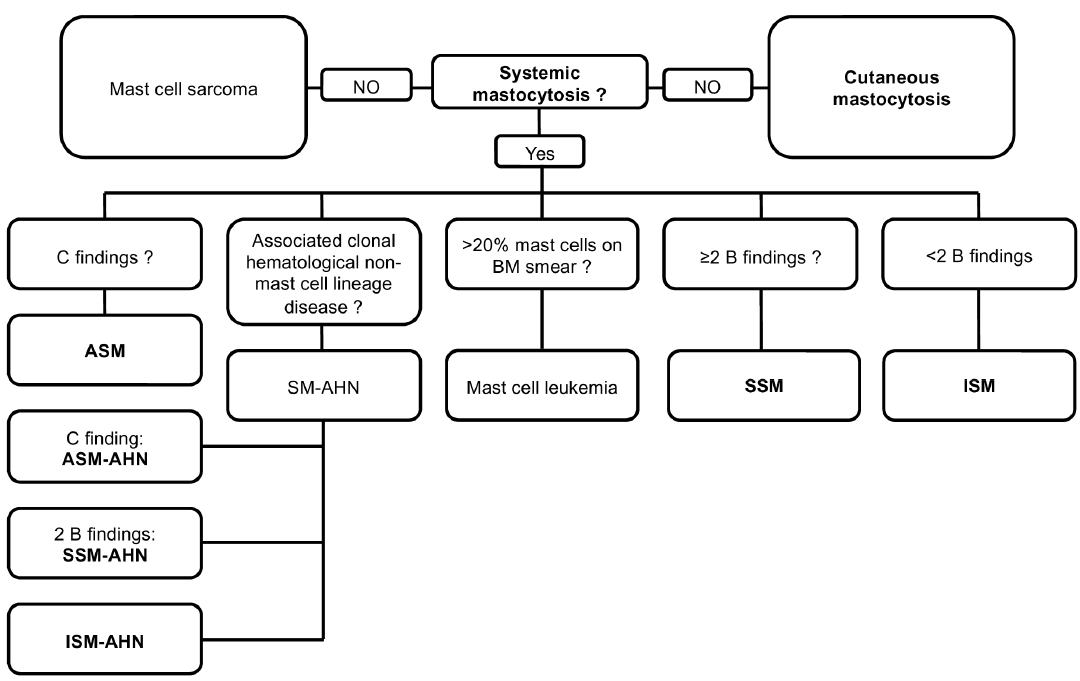
Figure 1. Diagnostic flow chart for mastocytosis. AHN, associated hematologic neoplasm; ASM-AHN, aggressive systemic mastocytosis with an associated hematologic neoplasm; BM, bone marrow; ISM, indolent systemic mastocytosis; MCL, mast cell leukemia; SM-AHN, systemic mastocytosis with an associated hematologic neoplasm; SSM, smoldering systemic mastocytosis; SSM-AHN, smoldering systemic mastocytosis with an associated hematologic neoplasm.